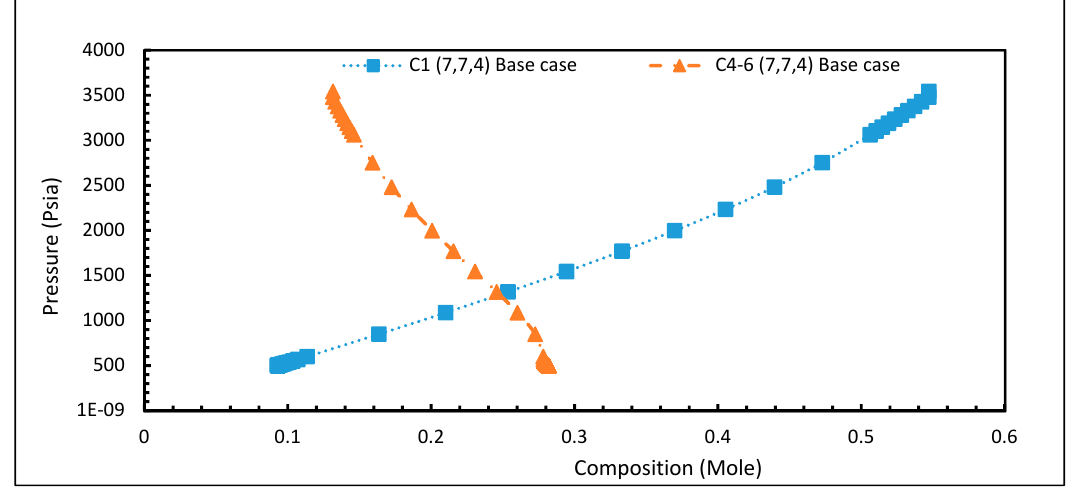
Figure 5. Pressure versus composition of the fluid components for the base case at the wellbore.